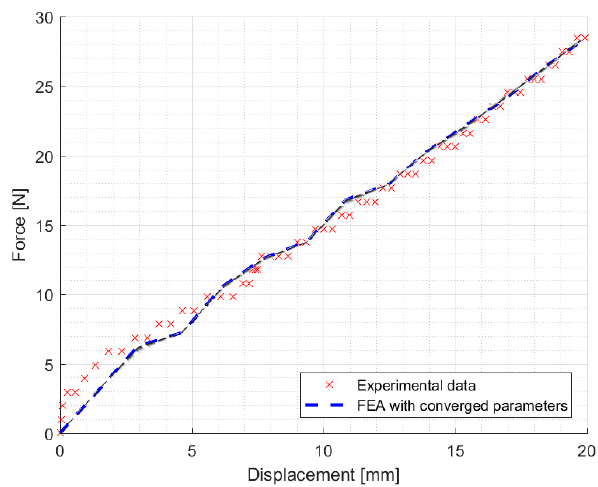
Figure 7. Fitting procedure of Ogden’s incompressible model using the inverse method.